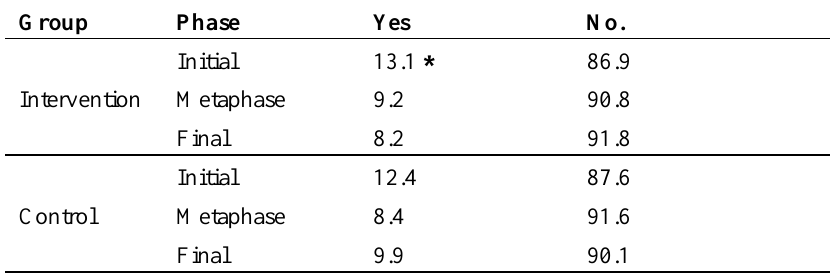
Table 7. Whether parents consumed western-style foods (%).